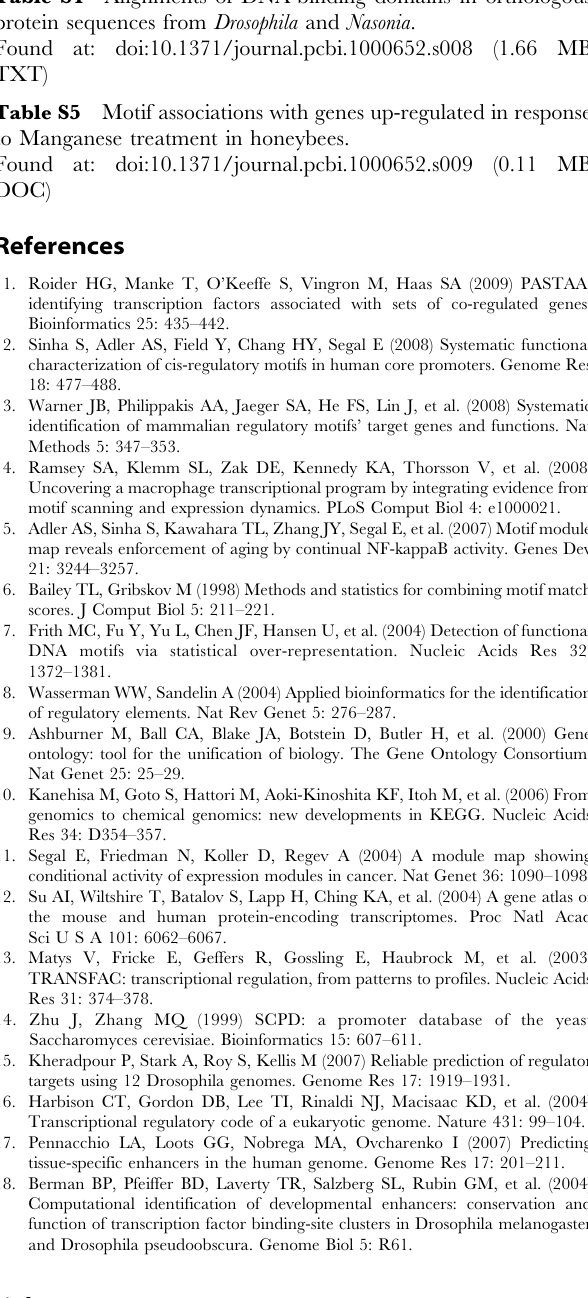
Table S3 Motif functional associations common to Nasonia and Drosophila .